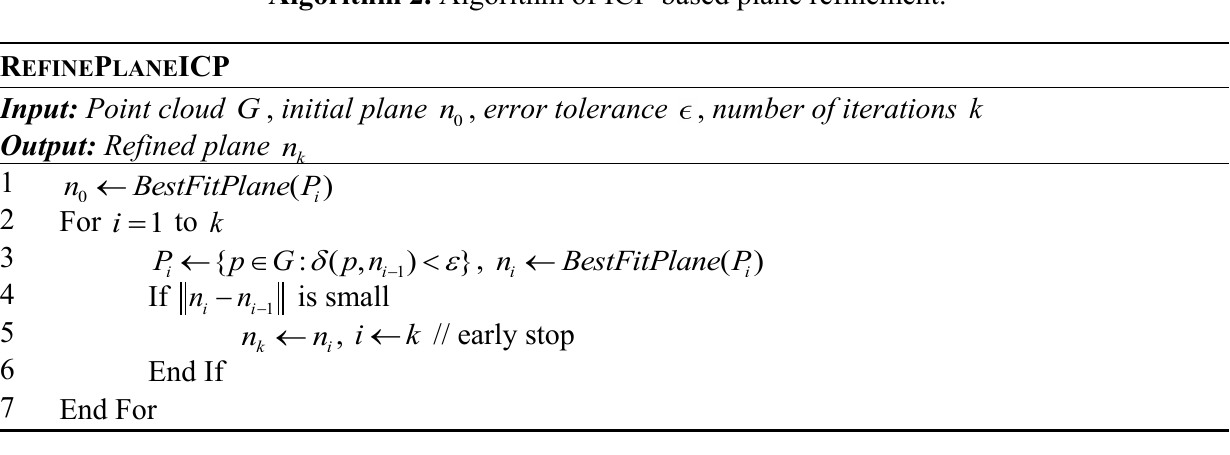
Algorithm 2. Algorithm of ICP-based plane refinement.